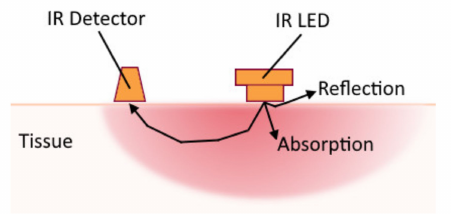
Figure 4. NIRS principle [65]. Infrared (IR) light is continuously emitted into muscle tissues by LED. The infrared light detector measures the amount of infrared light scattered by the tissue. The remaining portion of the light is reflected and absorbed by the surrounding